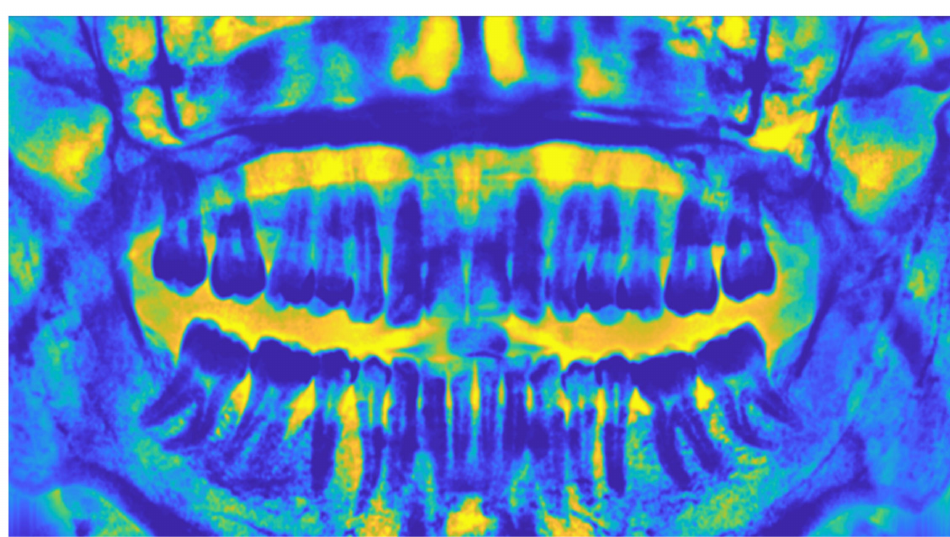
Figure 24. A 3D map of pixel